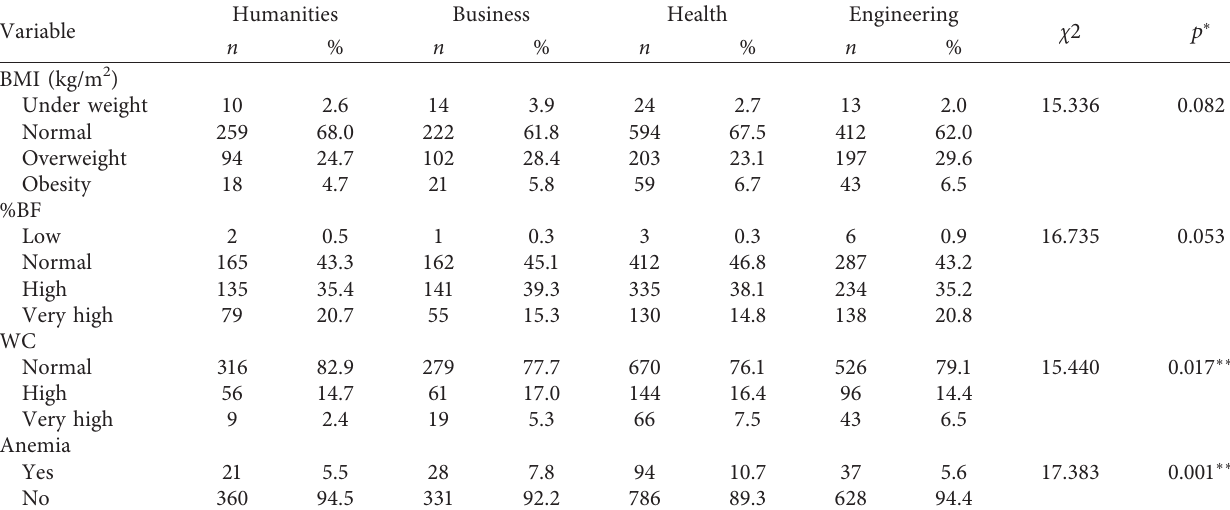
Table 4: BMI, % FB, WC, and anemia in humanities, business, health, and engineering